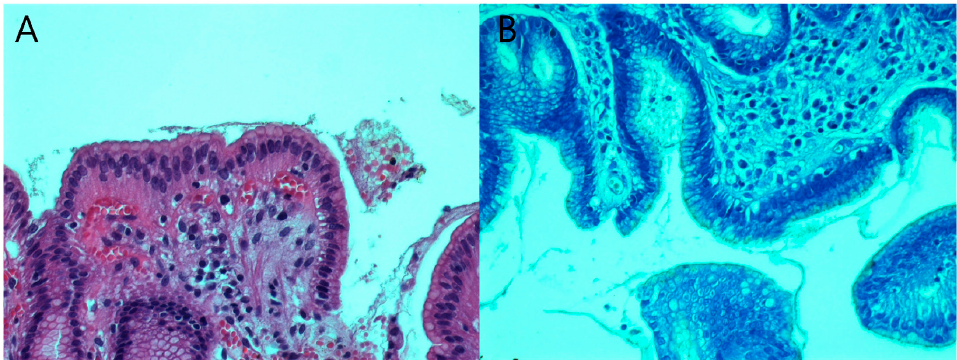
Figure 2. Microscopic view of Helicobacter pylori in antral gastric biopsy stained with ( A ) hematoxylin–eosin, and ( B ) Giemsa. ( A ) 200 × histological section of hematoxylin–eosin-stained antral gastric mucosa with inflammatory lymphoplasmacytic infiltration and vascular congestion; Helicobacter pylori can be seen within the mucus layer at the surface of gastric mucosa; ( B ) 400 × histological section of Giemsa-stained antral gastric mucosa with Helicobacter pylori colonization of the gastric glands, depicted as minuscule curved structures.